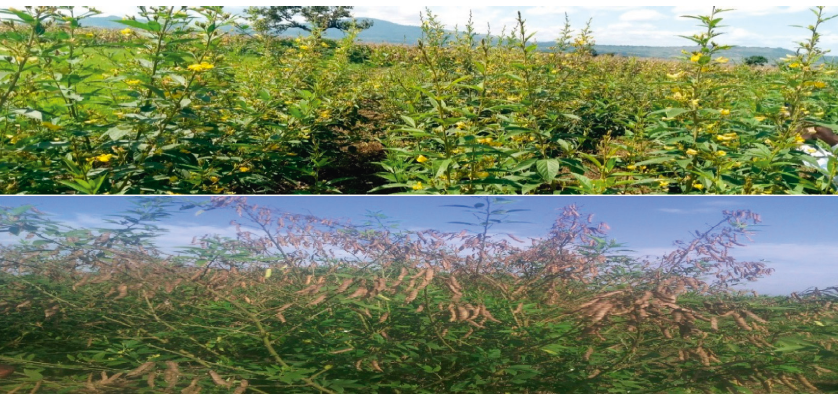
Figure 1: Field performance of pigeon pea adaptation trail. Table 2: Yield performance (kg ha − 1 ) of pigeon pea genotypes across locations during the 2018 and 2019 cropping seasons, South Ethiopia.